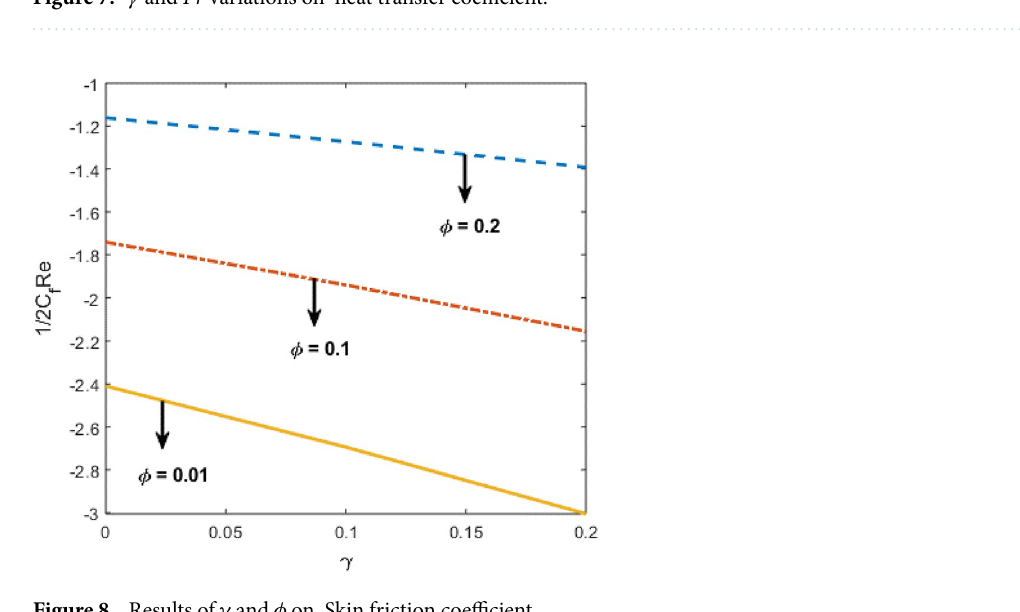
Figure 7. γ and Pr variations on heat transfer coefficient.